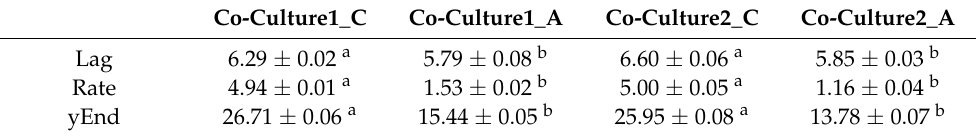
Table 3. Impedometric parameters describing the growth of the 2 co-cultures with (A) and without antimicrobial A. platensis extract